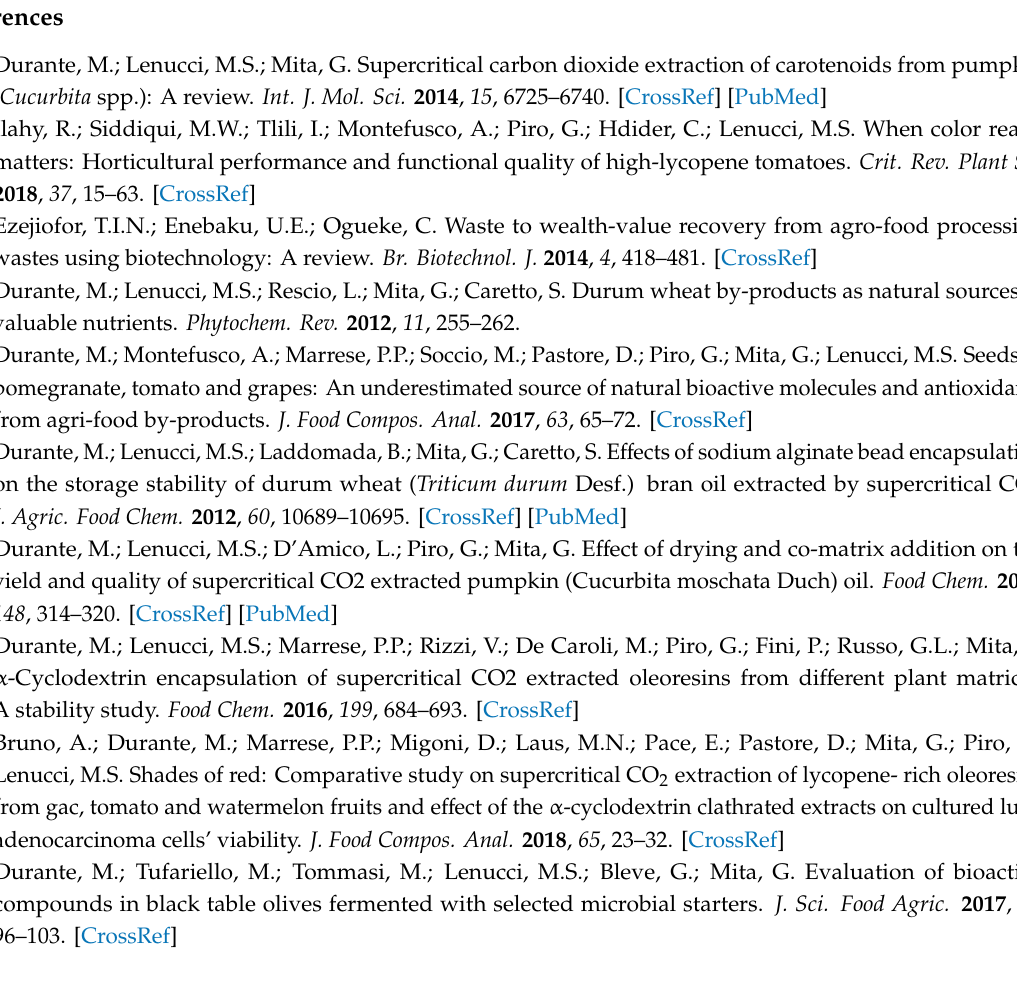
Supplementary Materials: The following are available online, Figure S1: HPLC chromatogram of polyphenol extracts from Taralli CTRL, OPC, and OPL. Samples were recorded with DAD at 278 nm. Peak numbers: 1, Hydroxytyrosol; 2, Tyrosol; 3, Verbascoside; 4, Oleacin; 5, Isoverbascoside; 6, Oleocanthal, Table S1: Polyphenols composition in virgin olive oil from Cellina di Nard ò and Leccino olive